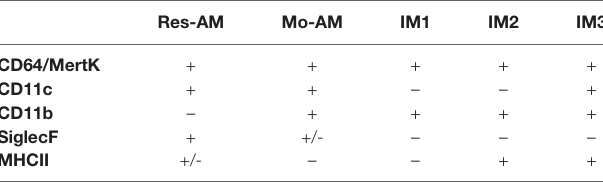
TABLE 1 | Cell surface expression of pulmonary macrophage